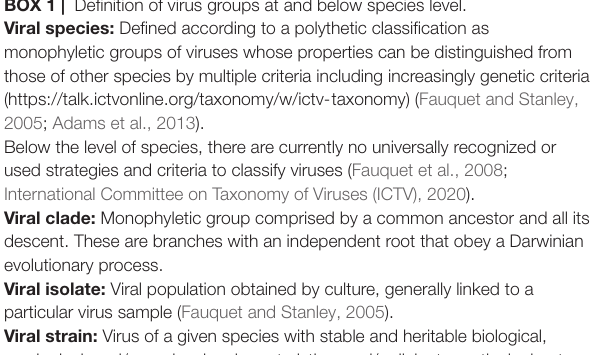
diagnosed in our institute as of 18 August 2021 ( Table 2 ). SARS- CoV-2 genotyping was performed by genome sequencing in our institute for at least 12% of positive diagnoses of SARS-CoV- 2 infection monthly, and for at least one fifth and one